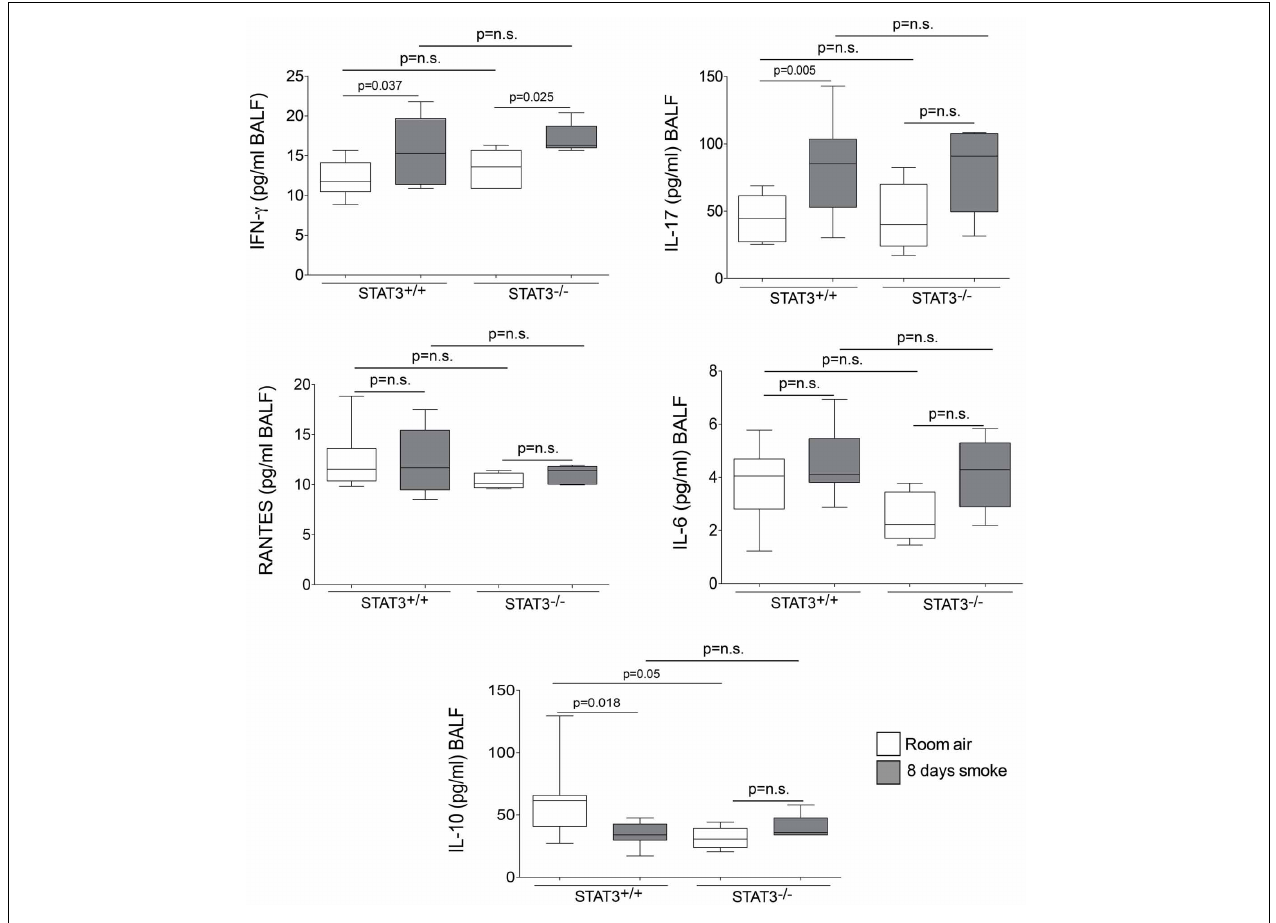
FIGURE 4 | STAT3 expression impacts on IL-10 BALF protein levels. Bioplex assays measured BALF cytokines (IFN- γ , IL-17, RANTES, IL-6, and IL-10) in room air and 8-day smoke-exposed STAT3 + / + and STAT3 − / − mice.